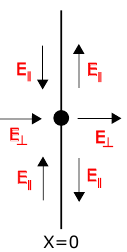
Figure 12 . Electric (cid:12)eld pro(cid:12)le in Minkowski space producible by Rindler bulk modes only.